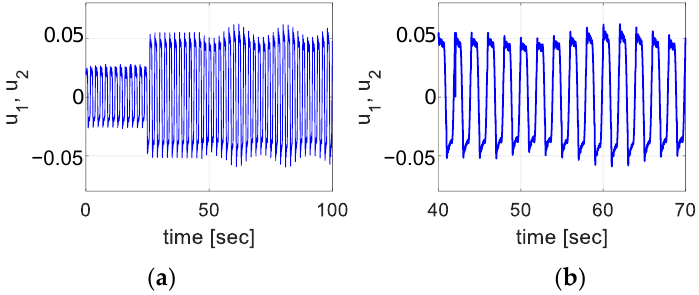
Figure 20. Control signals ( 𝑢 1 , 𝑢 2 ): ( a ) t = 0~100 s, ( b ) t = 40~70 s. Figure 19. Command angle (left) and measured angle (right).